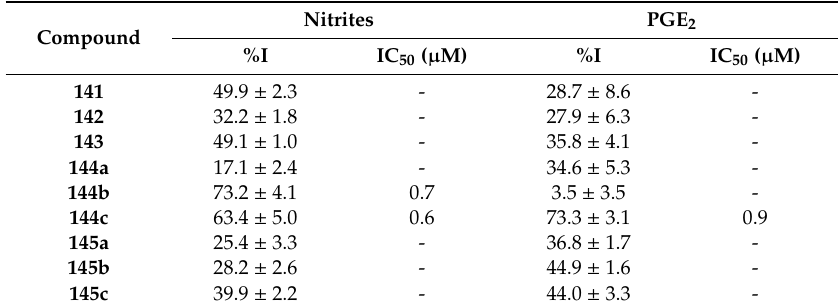
Table 24. Inhibitory activity of compounds 141 – 145 against the production of NO and PGE 2 in RAW 264.7 macrophages.